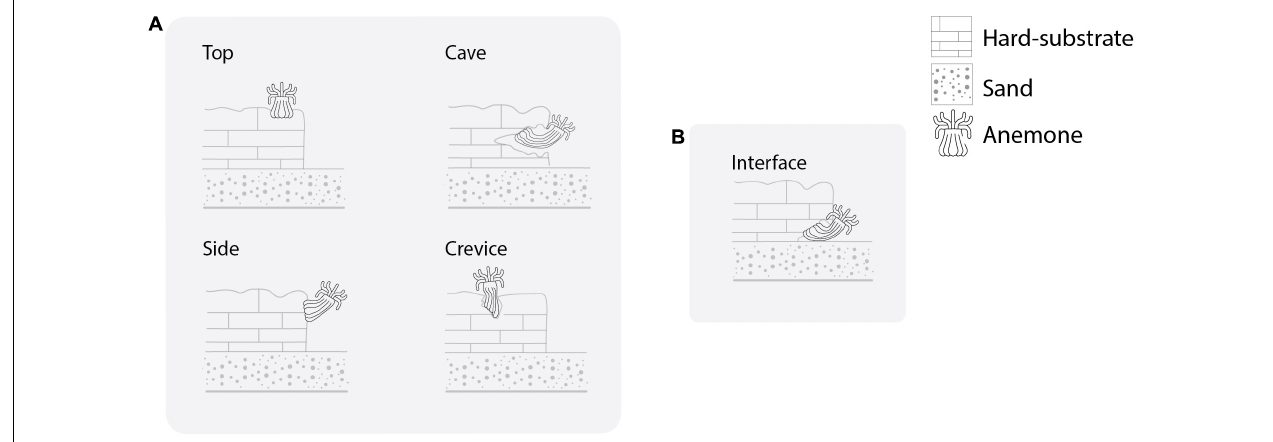
FIGURE 2 | Diagrams showing the positions in which Bartholomea annulata was found during surveys off the Mexican Caribbean coast: in crevices, caves or small holes located (A) on the top or lateral walls of coral fragments, limestone massif and rocks; (B) at the interface between hard substrate and the sandy